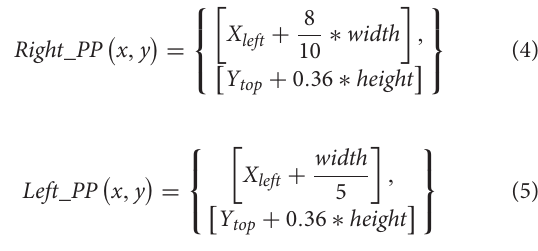
( X , Y ) refers to the upper left corner of the bounding boxes top left that enclose the ears, while width and height are the width and height measurements, respectively, of the preauricular point according to the closest point (see Figure 6B